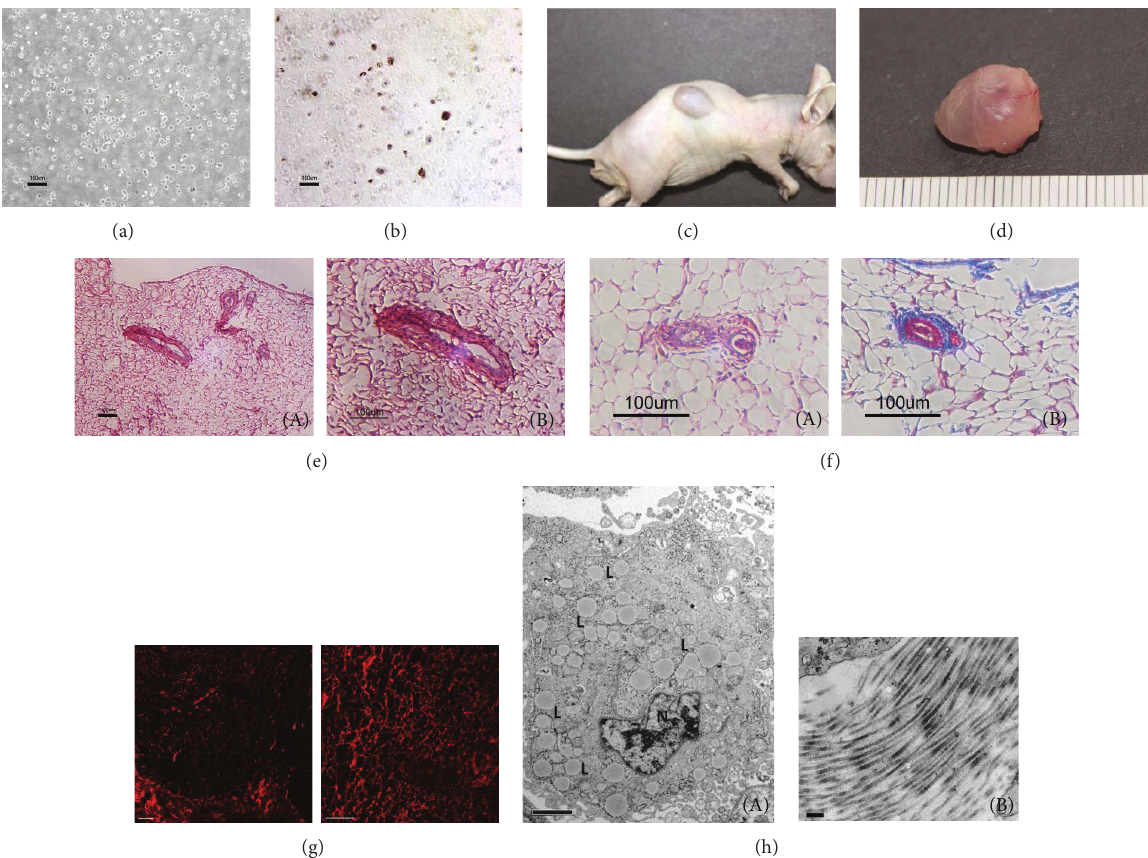
Figure 7: (a) Homogeneous cell encapsulation and high viability of embedded cells in the Pluronic F-127. (b) Oil Red O staining showed lipids in Pluronic F-127. (c) Subcutaneous injection of adipogenically induced eMSCs-hydrogels implants in nude mice after 4 weeks. (d) Gross view of the newly formed adipose tissue. (e), (f) H&E ((e)(A), (e)(B)) and Masson’s trichrome ((f)(A), (f)(B)) staining of adipose tissue sections showed that mature adipocytes and functional blood vessels are observed in the specimen, bars = 100 𝜇 m. (g) The CM-Dil labeled cells in tissue sections from the newly formed tissue. Bars = 100 𝜇 m. (h) Transmission electron microscopy shows the implants (A) and extracellular matrix (B), “N”: nucleus of cell; “L”: lipid droplet, bars = 2 𝜇 m, 200